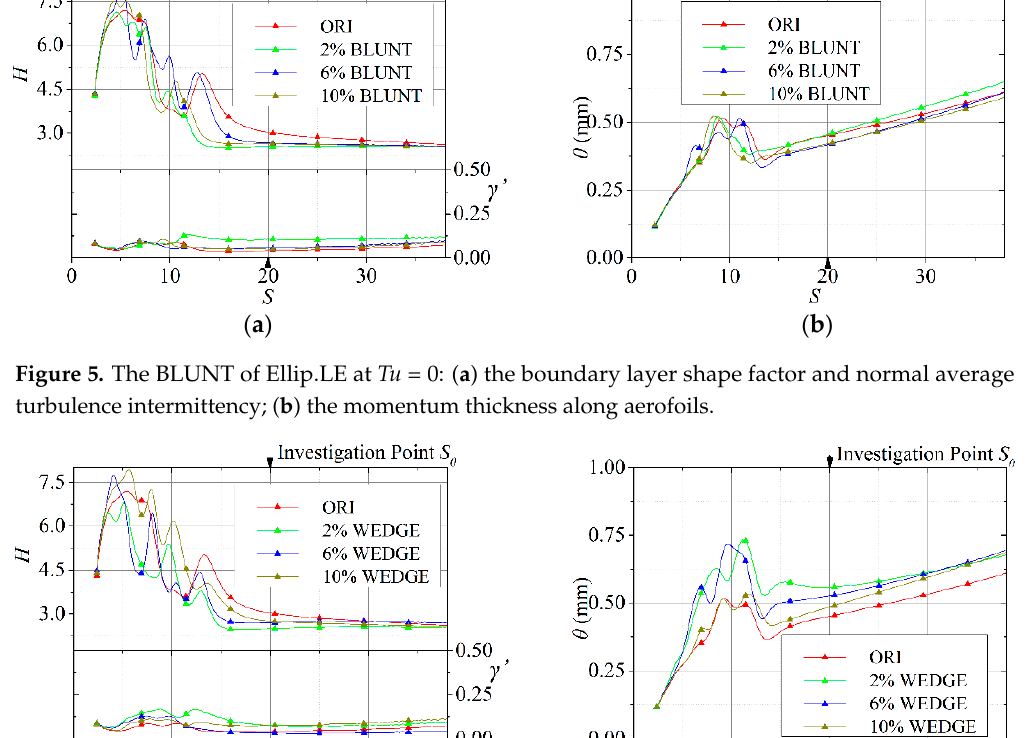
Figure 5. The BLUNT of Ellip.LE at Tu = 0: ( a ) the boundary layer shape factor and normal average turbulence intermittency; ( b ) the momentum thickness along aerofoils.